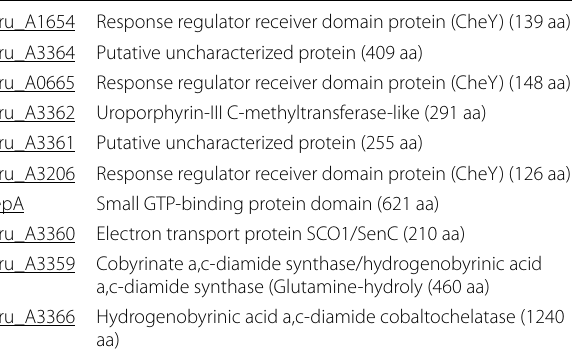
Table 5 Predicted functional partners of RegO as produced by STRING (version 11). (Scanning the attached QR code directs to the online analysis